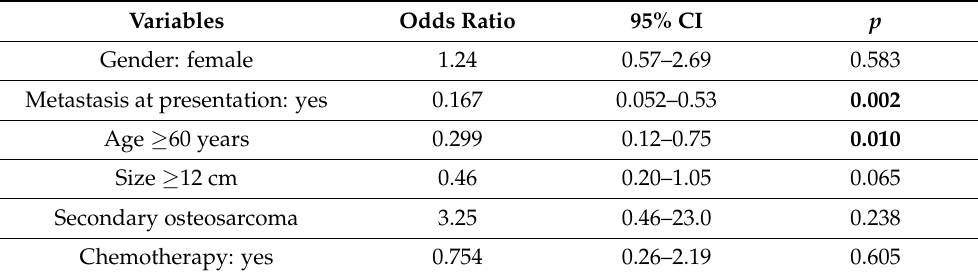
Table 5. Logistic regression model for the probability of undergoing surgical resection of pelvic